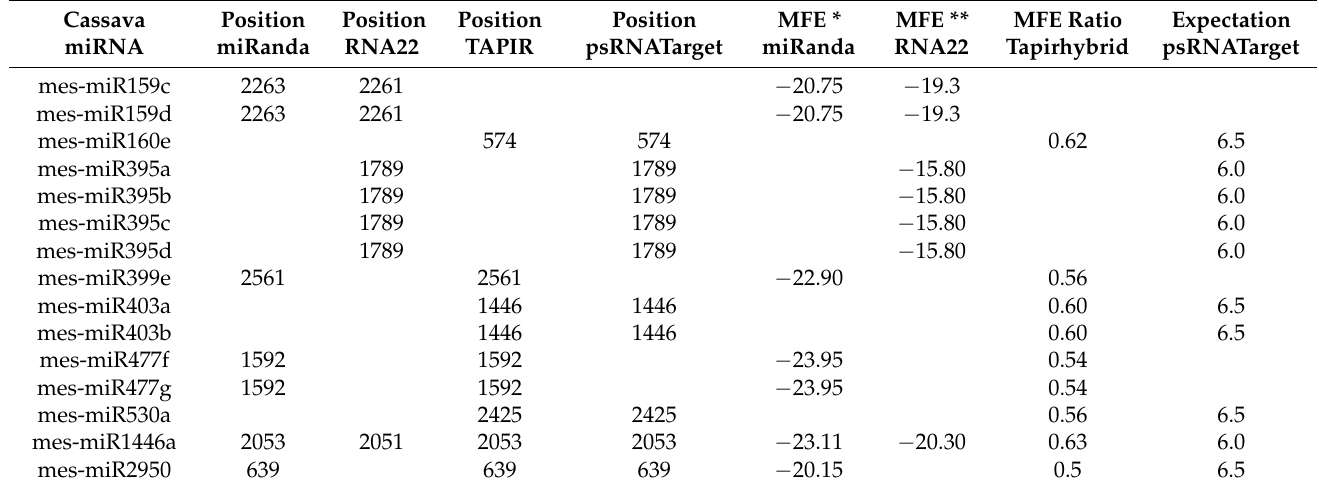
Figure 3. Union plot showing cassava miRNA-target pairs, predicted by all four algorithms used to analyze the cassava host-begomoviral data sets in this study. Table 3. Positions of consensus cassava locus-derived mes-miRNAs, predicted by at least three algorithms to target the ICMV-Ker genome.